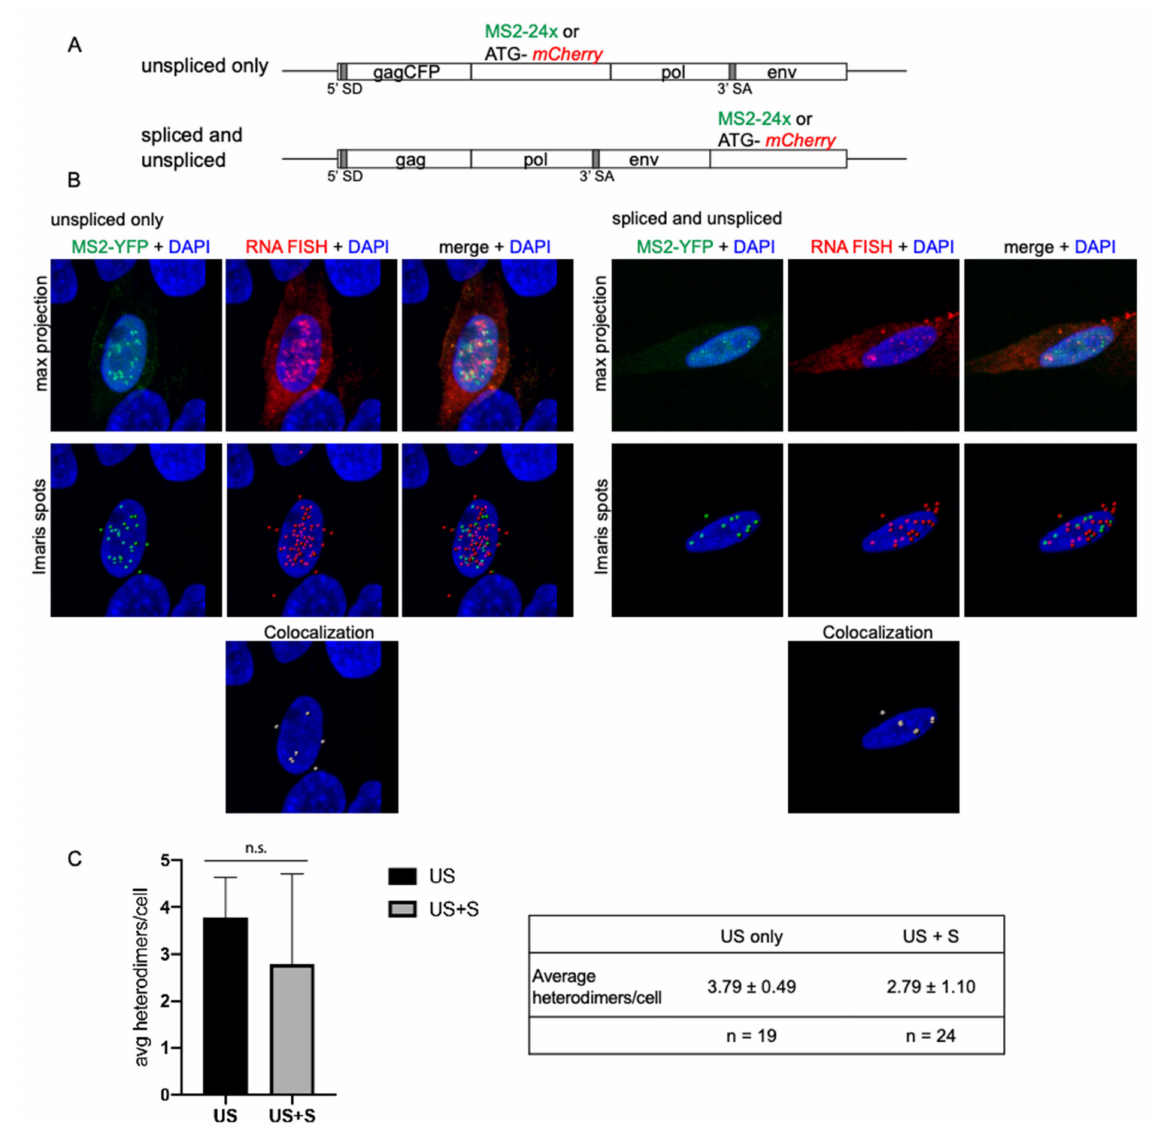
Figure 5. Contribution of spliced vRNA to intracellular genome heterodimers in RSV: ( A ) Schematic of the provirus constructs used to visualize only unspliced vRNAs (top) or spliced and unspliced vRNAs (bottom). Each proviral construct contains either a MS2-24x loop cassette or a non-coding mCherry RNA sequence used for RNA smFISH. The location of the 5 (cid:48) splice donor (5 (cid:48) SD) and 3 (cid:48) splice acceptor (3 (cid:48) SA) are indicated; ( B ) Representative confocal microscopy images of genome heterodimers in cells co-transfected with the proviral constructs containing ATG-mCherry (red) and MS2-24x loop cassette and MS2-YFP (green) are shown here. Cells were imaged by a z-stack through the width of the cell, as determined by WGA membrane staining, using a 63 × objective at 3.5 × optical zoom. A colocalization threshold of 0.5 µ m was used to determine whether two Spots were colocalized; ( C ) Comparison of the average number of heterodimers per cell between only unspliced vRNAs and spliced and unspliced vRNAs ( n = 19 cells and n = 22 cells, respectively). The average number of heterodimers per cell is 3.79 ± 0.49 in unspliced only and 2.79 ± 1.10 in spliced and unspliced vRNAs. Significant outliers were identified and removed using the Grubbs’ test ( p > 0.05, alpha = 0.5). No significant difference in the average number of genome heterodimers per cell was detected by unpaired t-test ( p = 0.2132). Image histograms were adjusted in the Imaris software for optimal